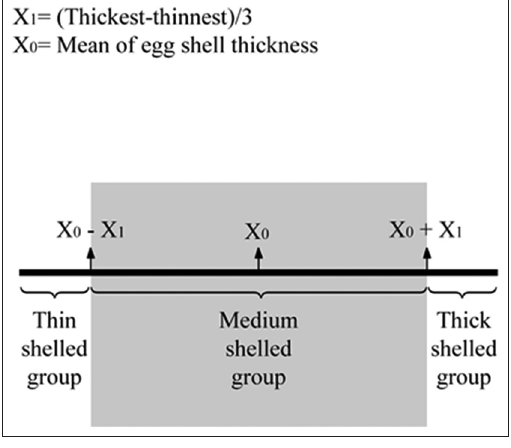
Figure-1: Classification method of eggshell thickness